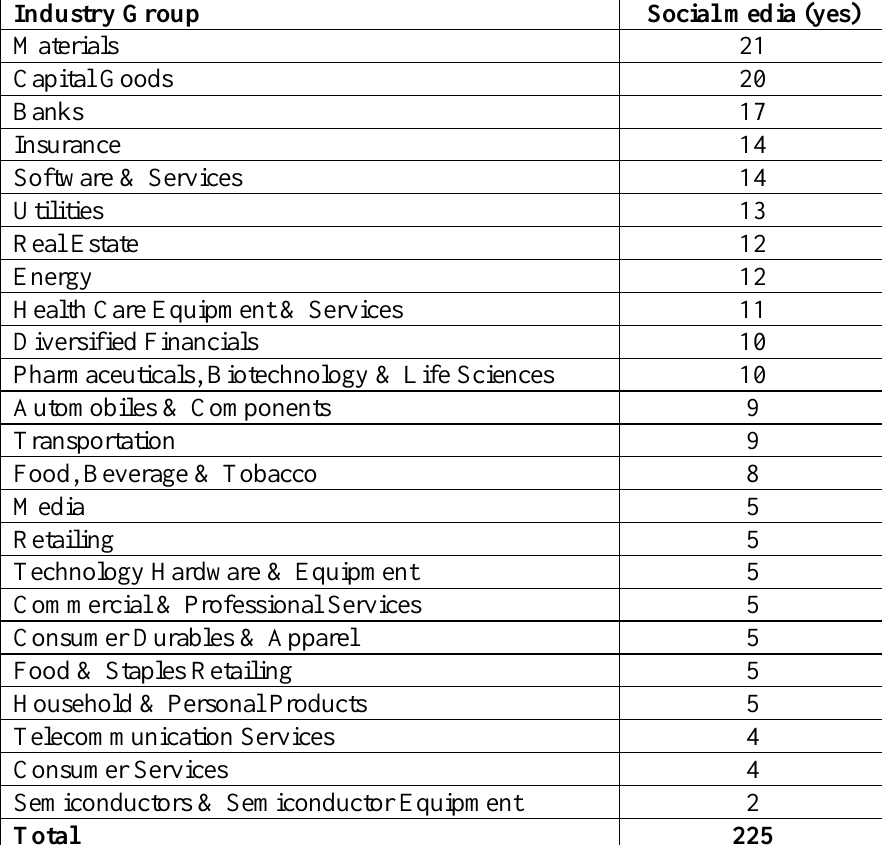
Table 7: Sectors of Companies that Use Most Social Media Industry